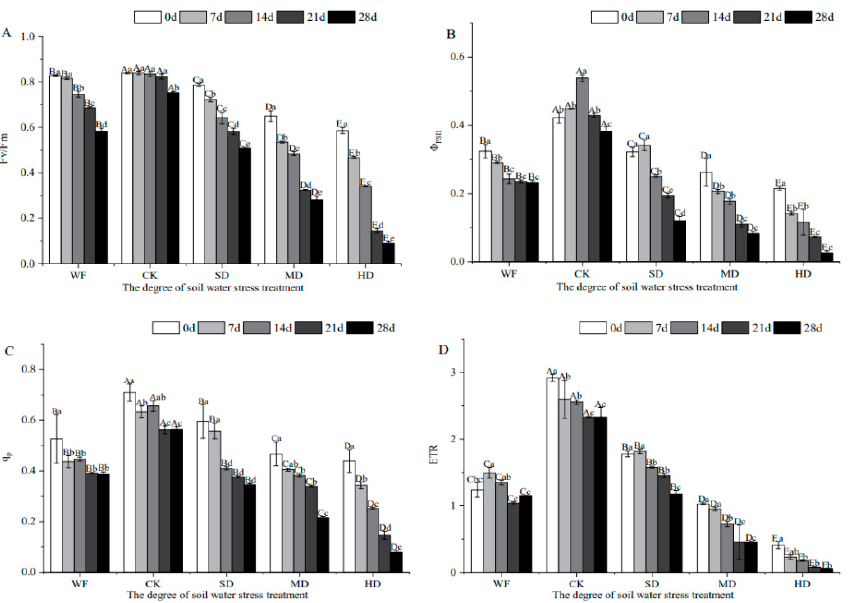
Figure 3. Effects of water stress on chlorophyll fluorescence characteristics of C. retusus leaves. ( A ) Effects of water stress on F v /F m of C. retusus leaves; ( B ) Effects of water stress on Φ PSII of C. retusus leaves; ( C ) Effects of water stress on q P of C. retusus leaves; ( D ) Effects of water stress on ETR of C. retusus leaves. Upper-case letters represent the variations in different treatment groups, and lower-case letters represent the difference in stress days within the group (significant). See the caption for Figure 1 for an explanation of abbreviations.